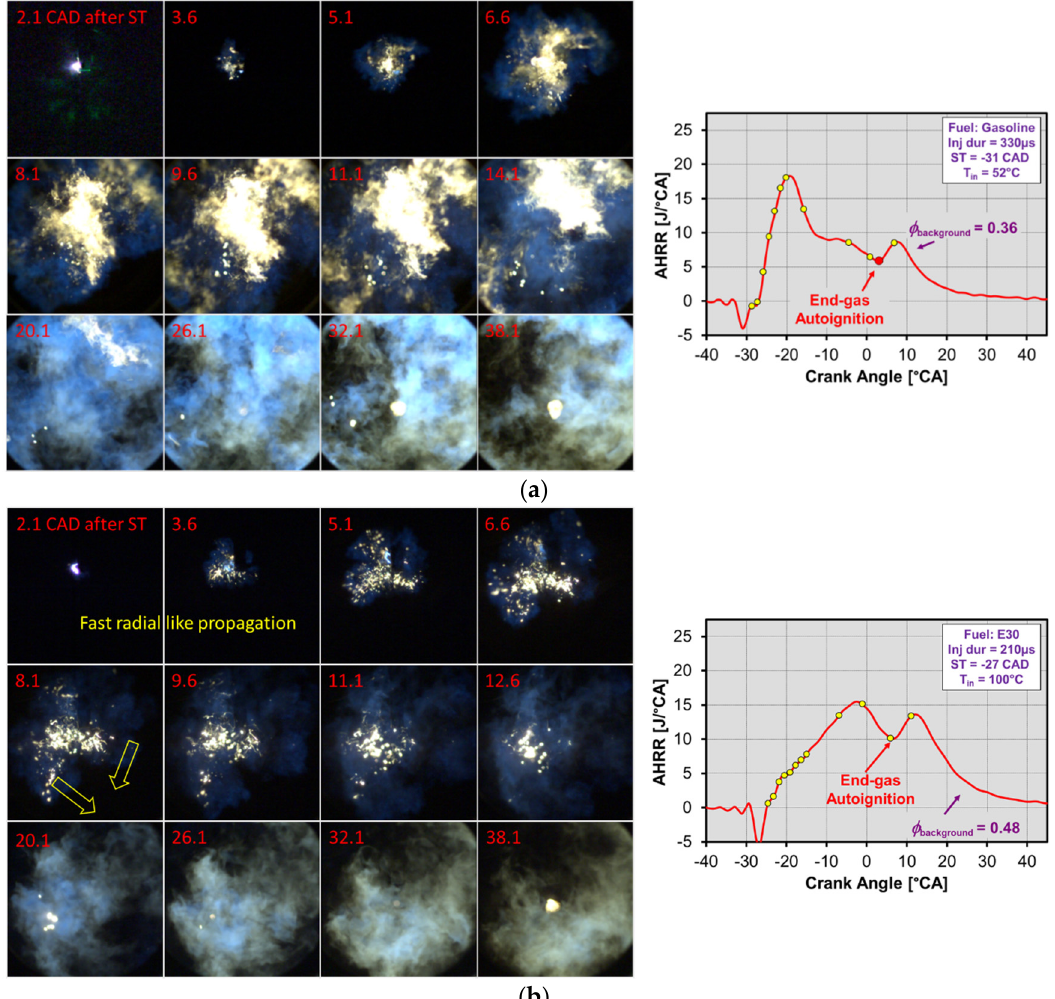
Figure 18. Flame propagation in PFS conditions: pilot injection duration ( a ) 330µs and ( b ) 210µs. The yellow dots on the AHRR trace correspond to the CADs where the images were acquired. In the first image of ( a ) the gain is 4 times the gain used in the other images, to highlight the presence of liquid scattering.